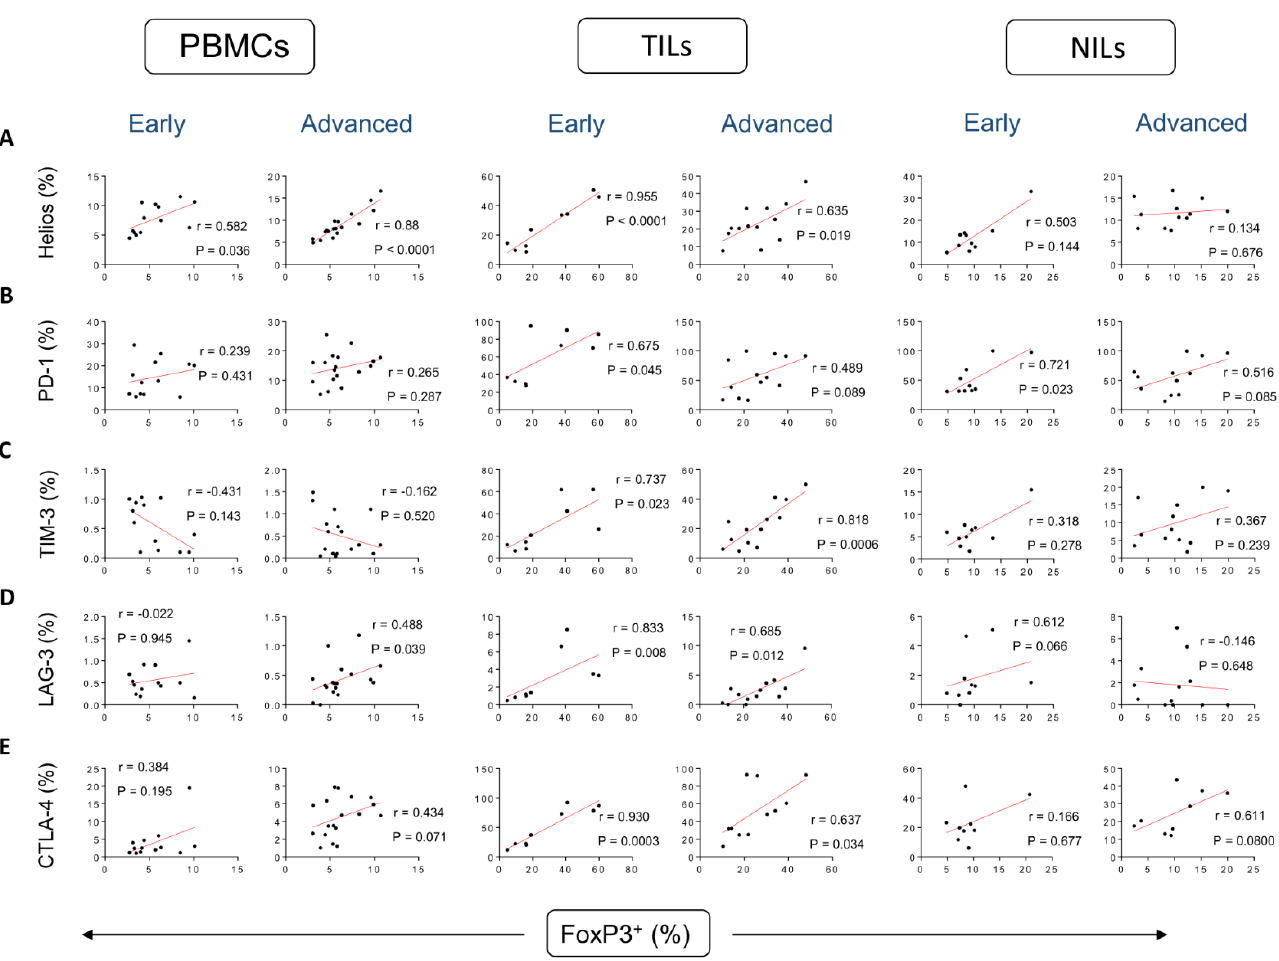
Figure 1. Correlations between frequencies of FoxP3 + and immune checkpoints in CD4 + T cells in CRC patients based on disease stages. Correlations between frequencies of CD4 + FoxP3 + Tregs with Helios + ( A ), PD-1 + ( B ), TIM-3 + ( C ), LAG-3 + ( D ), and CTLA-4 + ( E ) in PBMCs, TILs, and NILs in CRC patients with early and advanced stages.